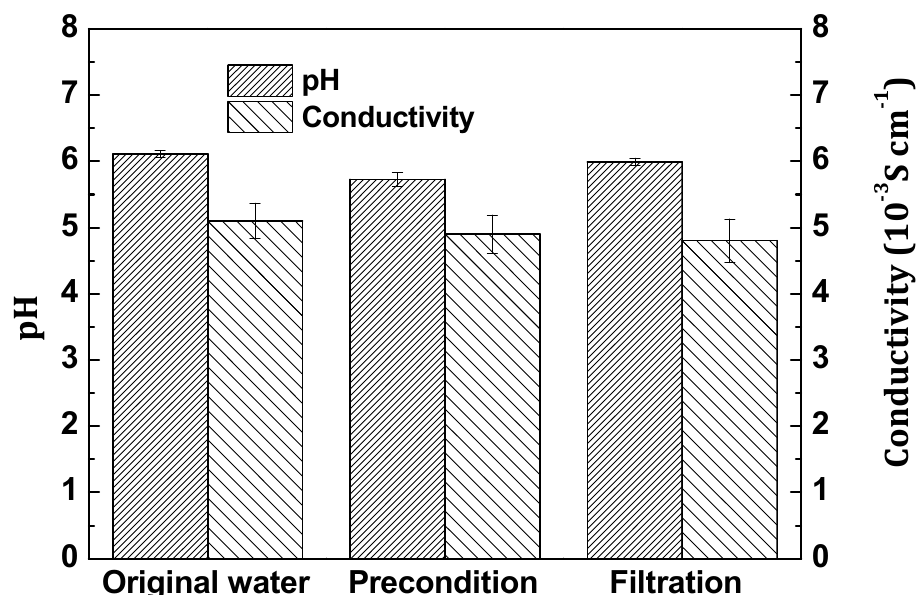
Figure 4. The membrane conductivity and pHs of the permeate (before filtration, after preconditioning and after the actual filtration) in the dead-end filtration using water as feed. Experimental conditions: operating pressure 2 bar, room temperature.